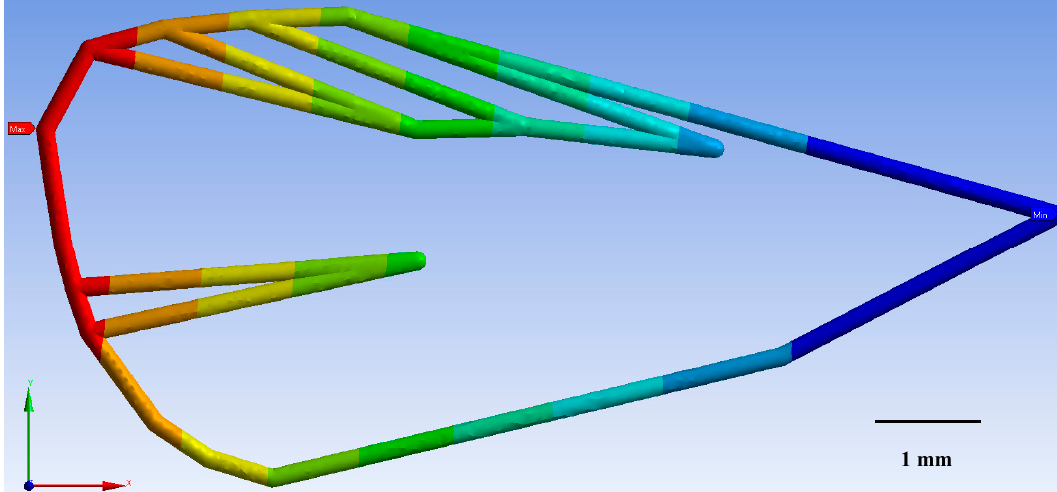
Figure 8. Codling moth from the integrated population exhibited a maximum deformation (red area) of 0.0112 mm around landmark 8 (Figure 1), for a maximum wind speed of 4.2 m/s − 1 . The minimal deformation of 0.0013 mm was concentrated around landmark 17 (light blue area on figure).